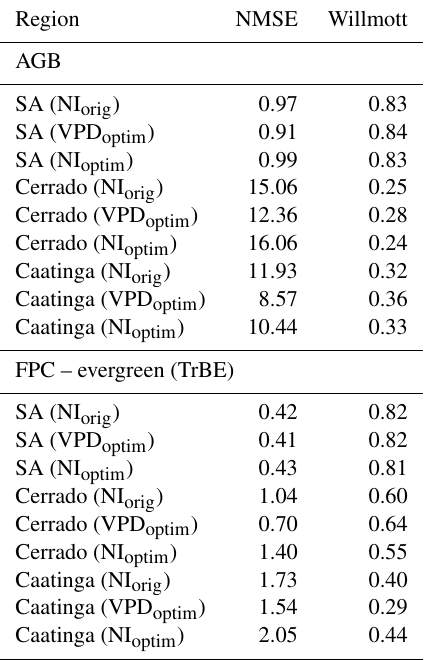
Table 3. Comparison of the results for AGB and the TrBE PFT cover in terms of NMSE and the Willmott coefficient of agreement between NI orig , VPD optim , and NI optim in South America (SA), in the Cerrado and in the